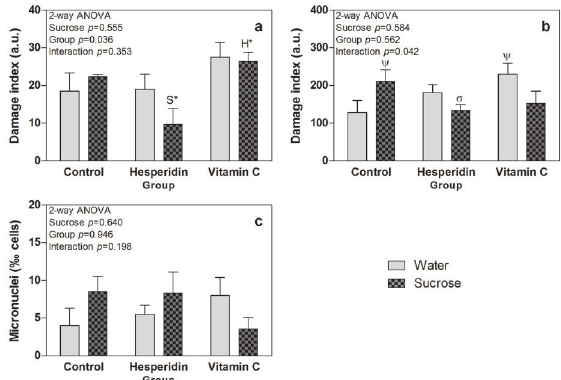
Figure 3 - Influence of vitamin C and hesperidin on damage index in blood ( a ) and brain ( b ) samples, and on micronuclei in bone marrow ( c ) of rats treated with sucrose. p : level of significance according to post-hoc test in two-way ANOVA test in relation to sucrose control (S) and hesperidin (H) at * p <0.05. In the case of significant interaction, Greek letters indicate statistical significance according to t-test in relation to water (ψ) or sucrose control (σ) at p <0.05.